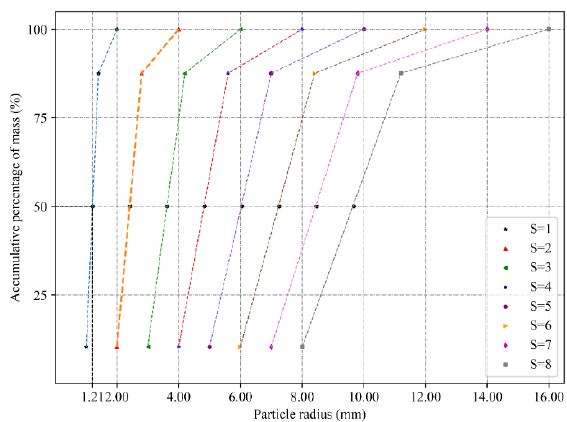
Figure 1. Sample of river gravel.